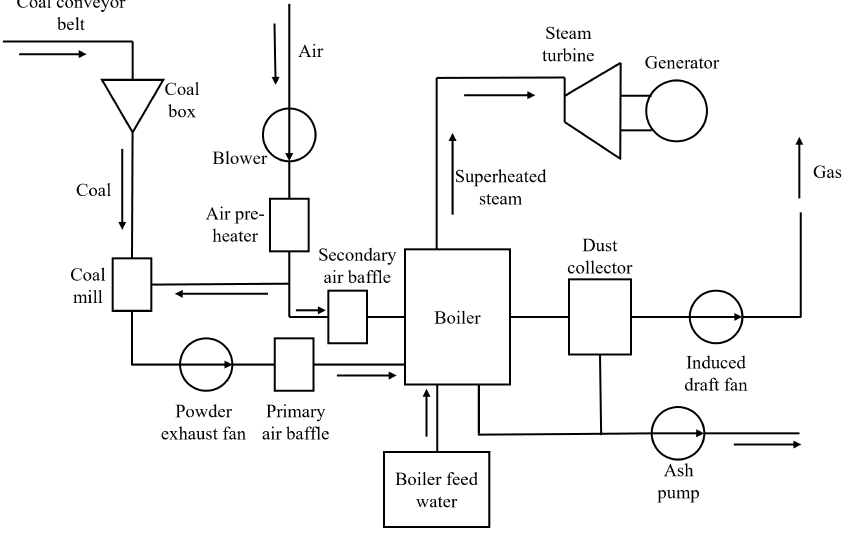
Figure 5. Process flow chart of coal-fired power plant.